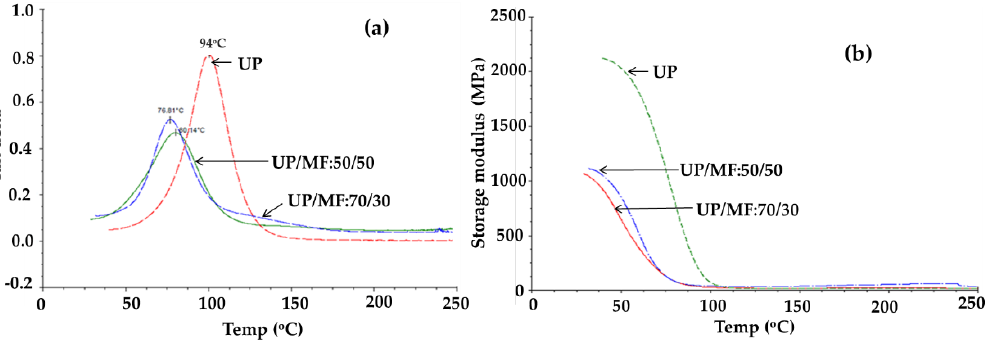
Figure 3. ( a ) Tan δ and ( b ) storage modulus vs. temperature curves for cured resin of UP, UP/MF:70/30, and UP/MF:50/50. Table 3. T g s and storage moduli of cured cast resin samples of UP and UP/MF blends from